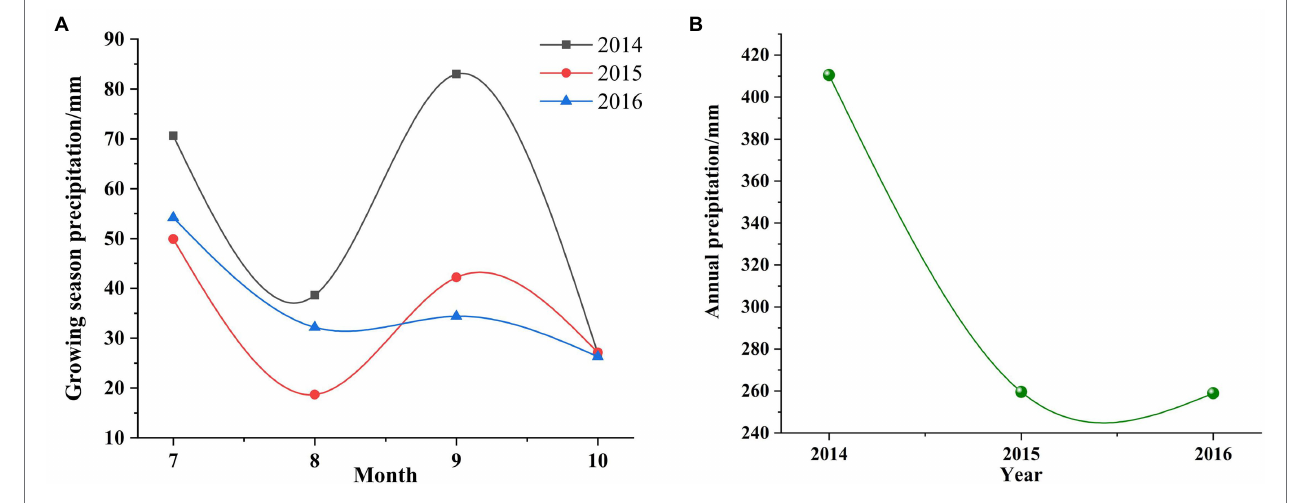
FIGURE 5 | Precipitation during the growing season (A) and Annual Precipitation (B) , 2014–2016.